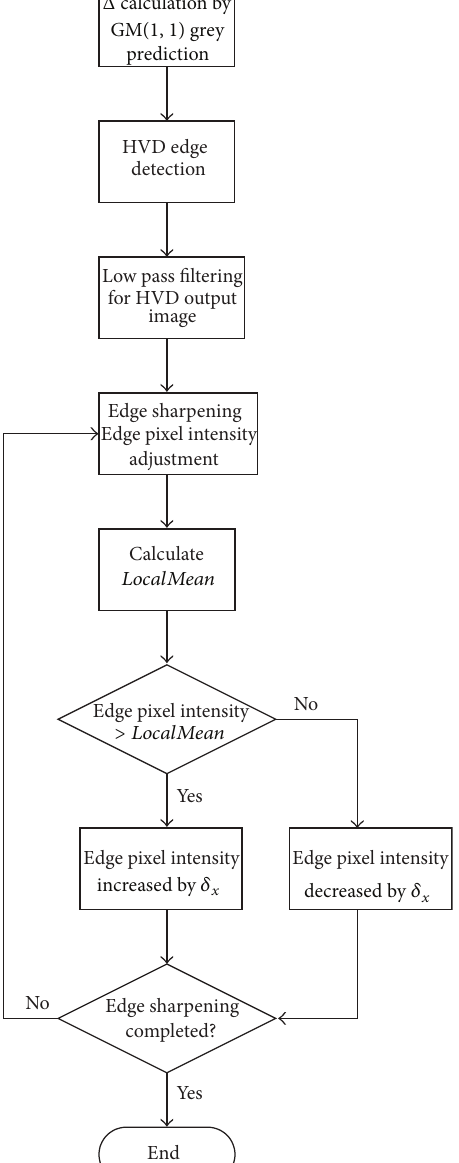
Figure 3: Procedure of the proposed image sharpening